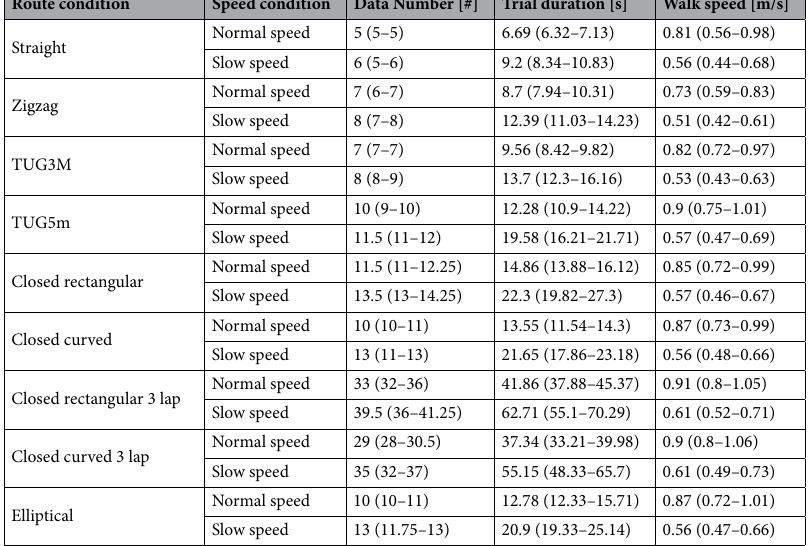
Table 2. Data number, the trial duration and the walk speed of the experimental results in each condition based on the route conditions and the speed conditions in median (1st quartile–3rd